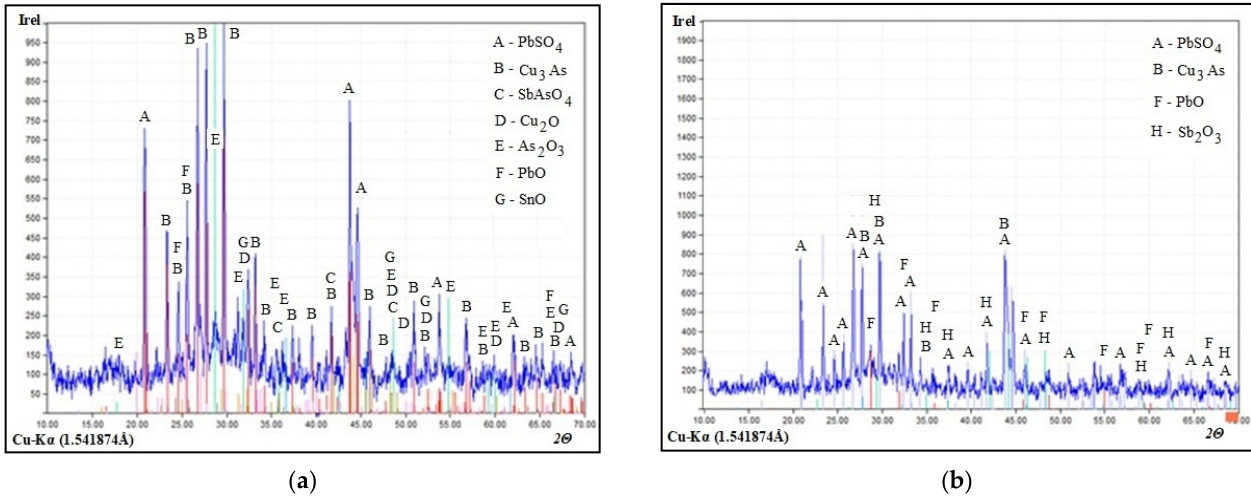
Figure 6. X-ray diffraction patterns of homogenized slime after the electrorefining of the anode with sample code An-2: ( a ) working electrolyte temperature of T1 = 63 ± 2 °C and ( b ) working electrolyte temperature of T2 = 73 ± 2 °C.